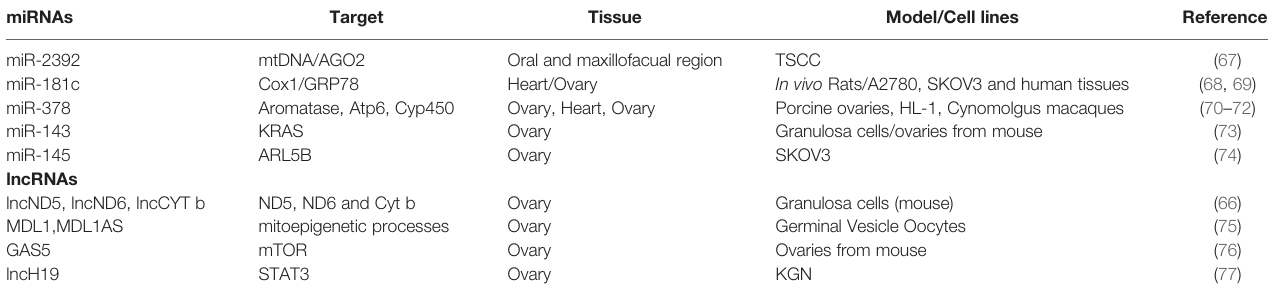
TABLE 1 | miRNAs and lncRNAs and their targets for mitochondrial function in ovarian aging.